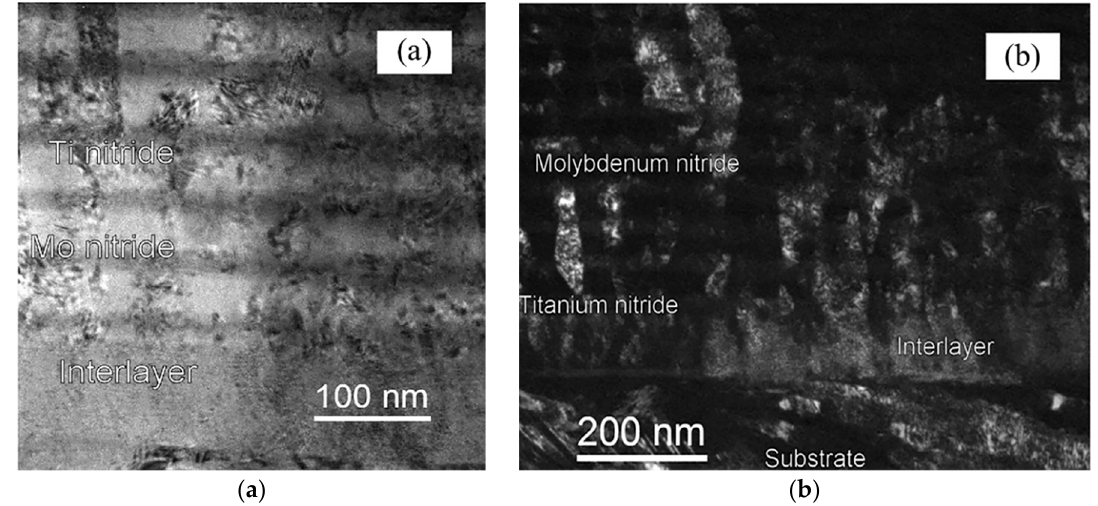
Figure 12. TEM bright ‐ field ( a ) and dark ‐ field ( b ) images of the TiN/MoN multilayer coatings with an